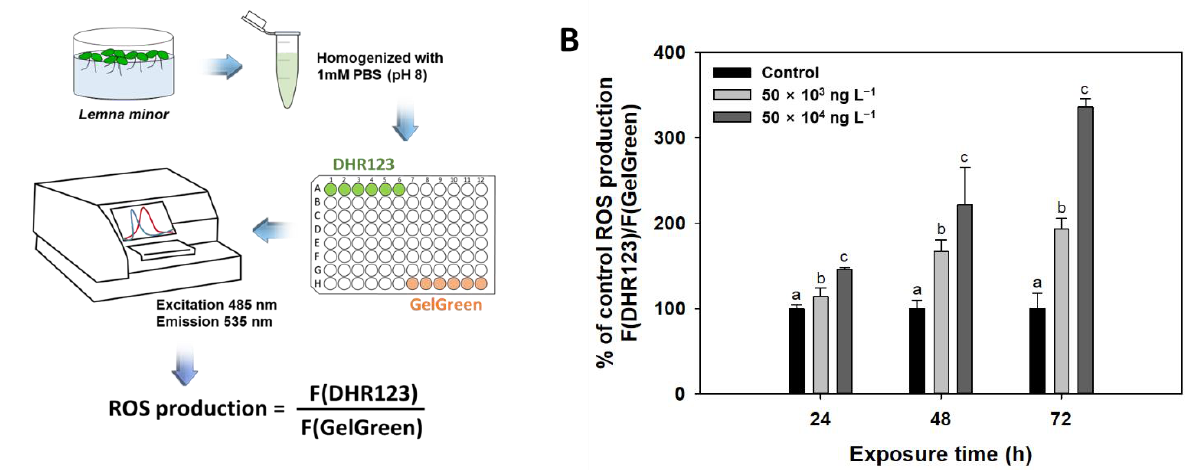
Figure 4. Experimental procedure used to assess ROS levels as DHR123 values normalized to DNA content. Supernatants from Lemna minor homogenates containing 1 mM phosphate-buffered saline (PBS; pH 8) were incubated with 30 μM DHR-123 for 20 min at room temperature ( A ). Reactive oxygen species (ROS) production in L. minor exposed to increasing concentrations of diuron (0, 50 × 10 3 , 50 × 10 4 ng L −1 ) for 24, 48, and 72 h ( B ). Bars represent the mean ± standard deviation of three replicates. Different letters indicate statistically significant differences at p < 0.05 (one-way ANOVA, LSD).